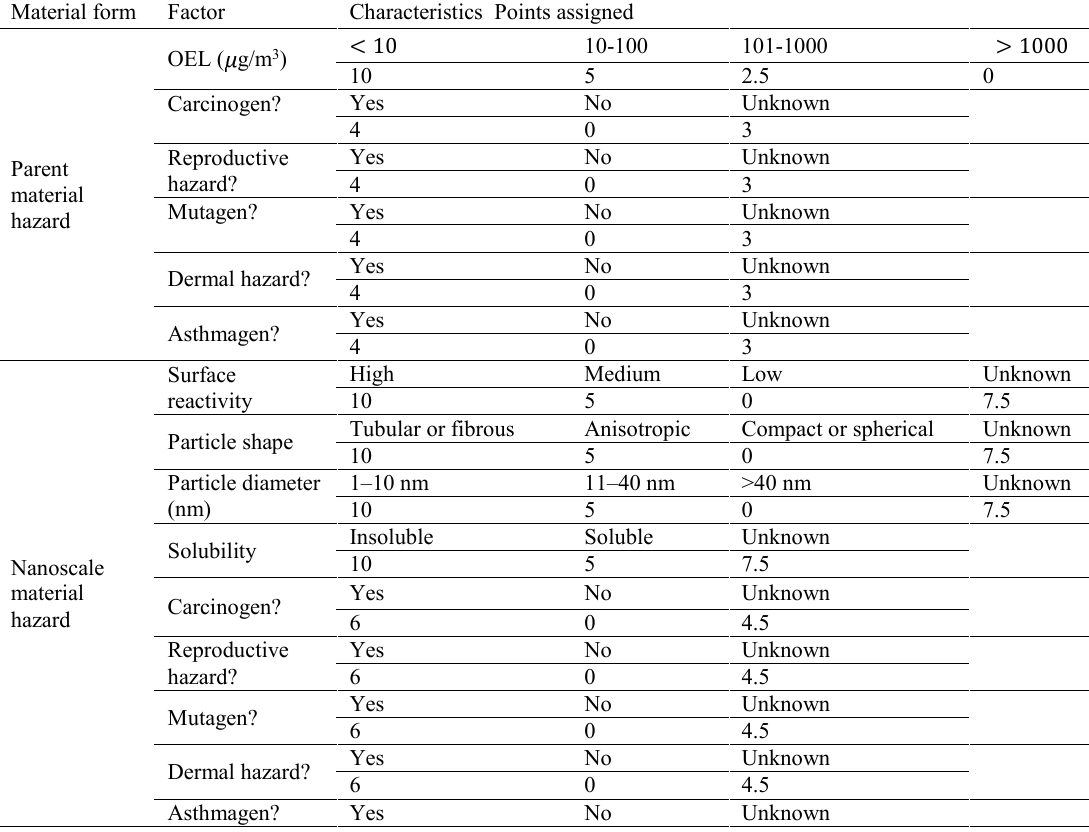
Table 2. Hazard severity factors of Control Banding Nanotool Material form